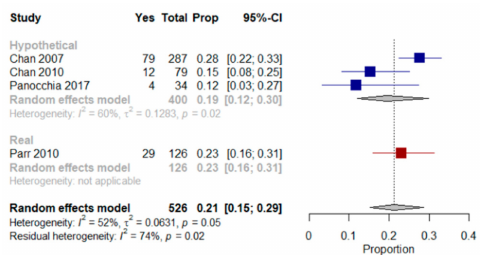
Figure 1. Forest plot comparing the willingness to receive life-sustaining treatments: Shows results (%) from studies where the context was a hypothetical scenario, a real scenario or regardless of the scenario patients were presented with when end-of-life care preferences were